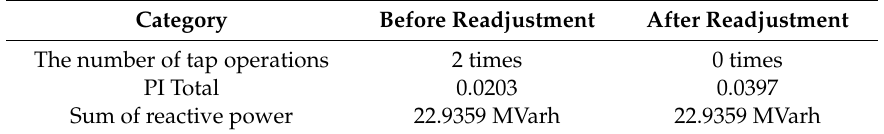
Table 9. Comparison of the number of tap operations, PI total, sum of reactive power with / without the proposed method of case 2 for nominal voltage.